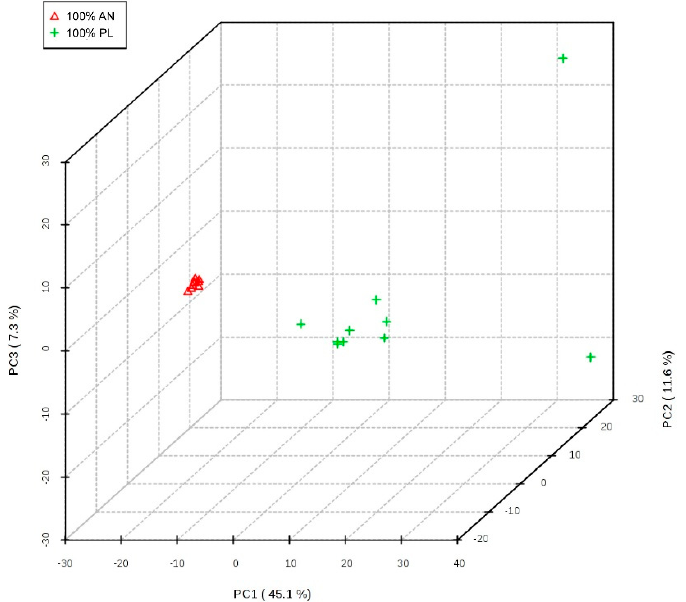
Figure 3. The overall metabolic profiles of the plasma of the two groups. Figure legend: The overall metabolic profiles of the plasma of the two groups of pregnant rats were examined using PCA. The metabolic profiles of the two groups of pregnant rats could be naturally distinguished. 100% AN: 100% animal protein group, 100% PL: 100% plant protein group, PC: principal component.